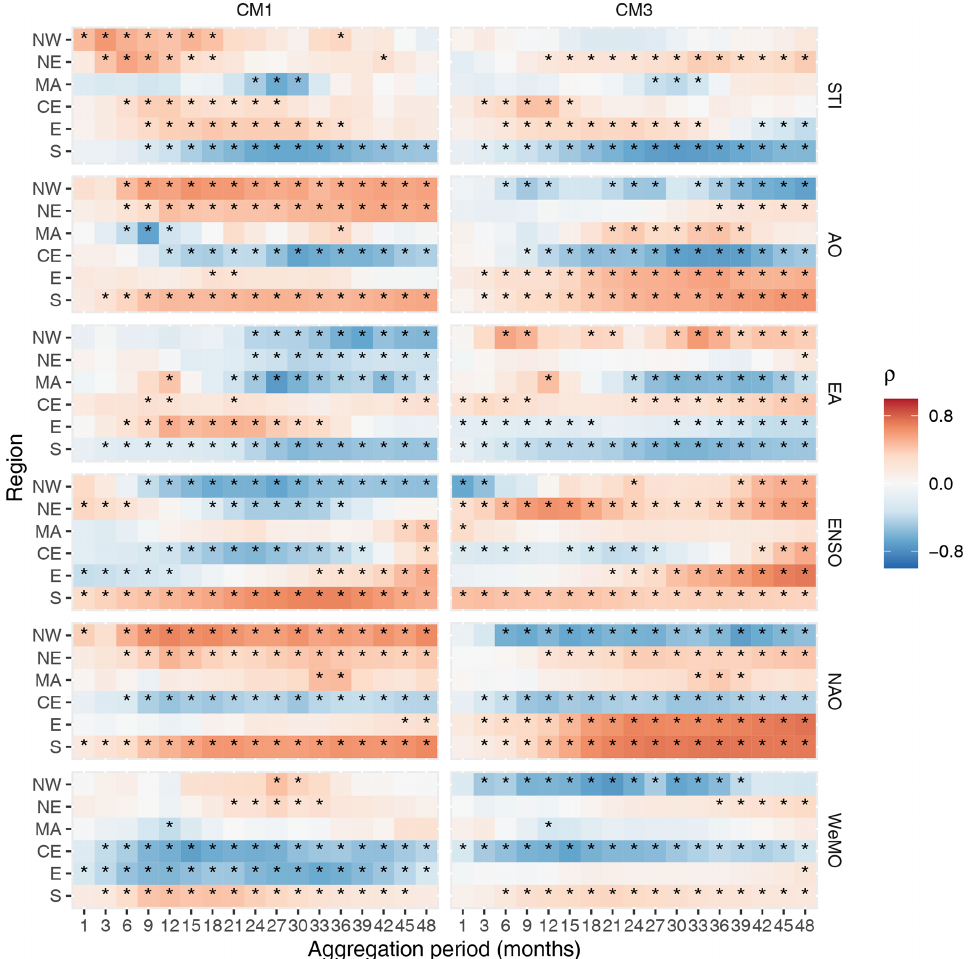
Figure 5. Correlation coefficients ( ρ ) between time series of climate indices and impact occurrences for each sub-region using one of the most (CM1) and the third most (CM3) censoring counting methods. Asterisks indicate the significance ( p < 0 .